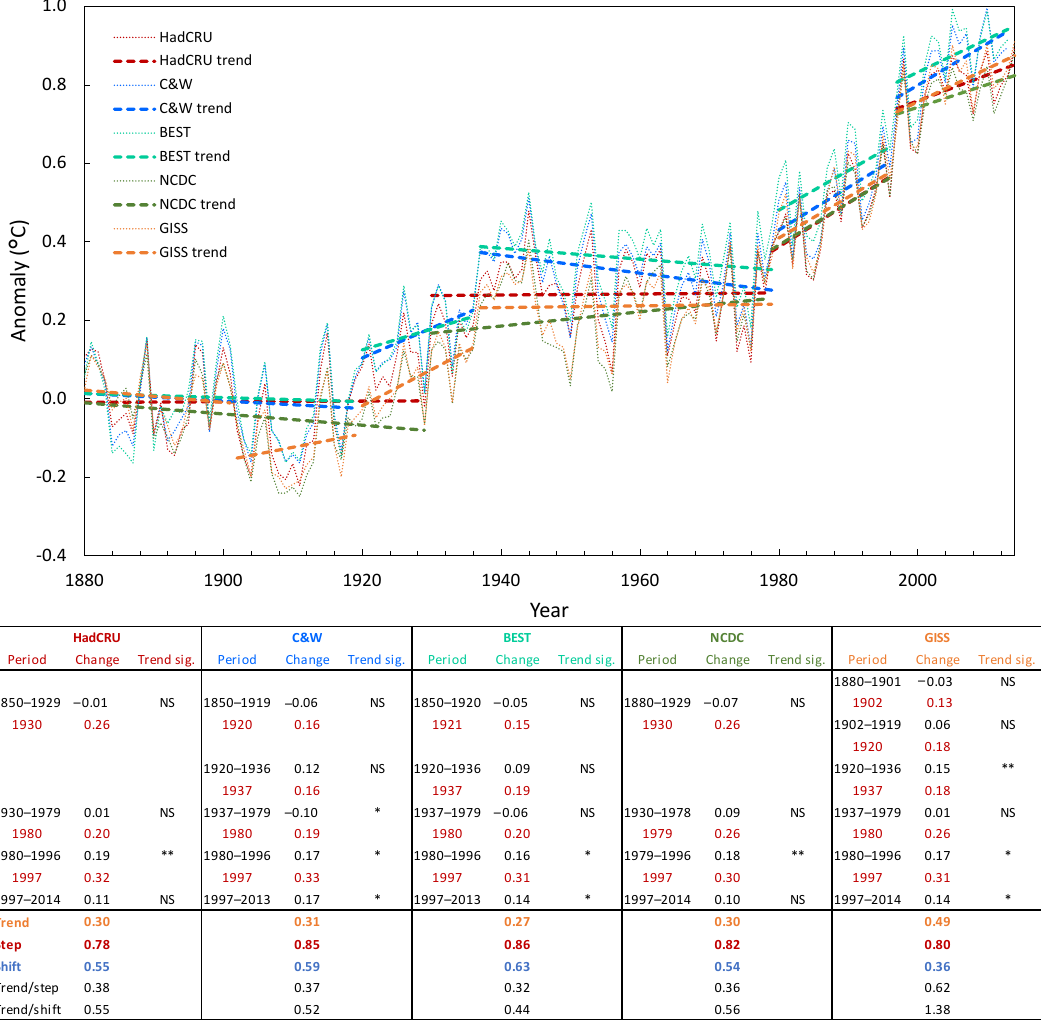
Figure 3. Mean global anomalies of surface temperature with internal trends. The annual anomalies (dotted lines) from five records (Had- CRU, C&W, BEST, NCDC, GISS) are taken from a 1880–1899 baseline. Internal trends (dashed lines) are separated by step changes detected by the bivariate test at the p <0.01 error level. The size of each step (in red) and change in temperature of each internal trend (in black) is shown in the figure table along with its significance, where NS is p >0.05, ∗ is p >0.01<0.05 and ∗∗ is p <0.01. Totals of trends, steps, shifts (change from one trend to the next) and ratios are also